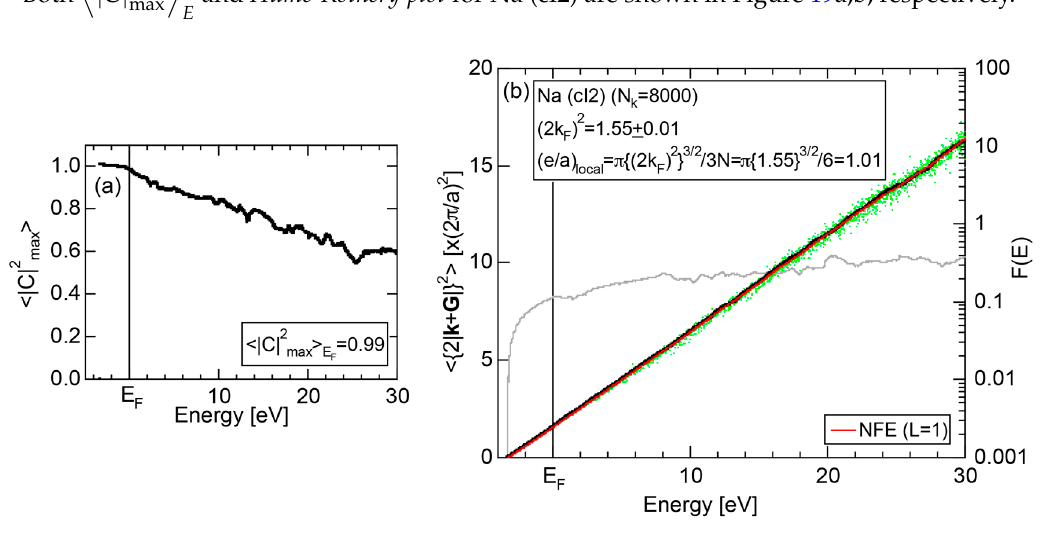
(cid:12) (cid:12) 2 j (cid:12) (cid:12) ≥ 0.2 (cid:12) C (cid:12) k i + G p 2 pj  ≥ 0.2 (green dots). k i + G